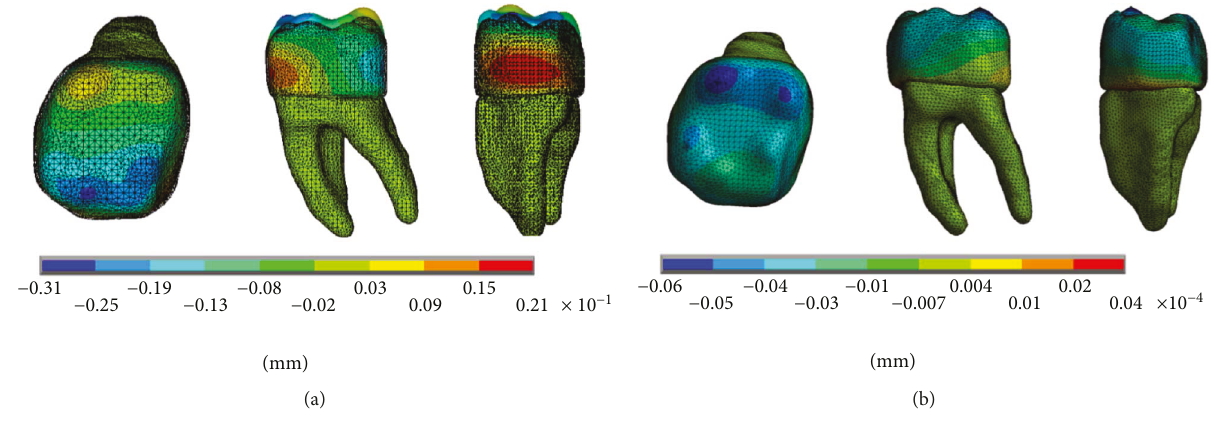
Figure 17: Displacements in the y -axis. (a) Noncontact. (b)